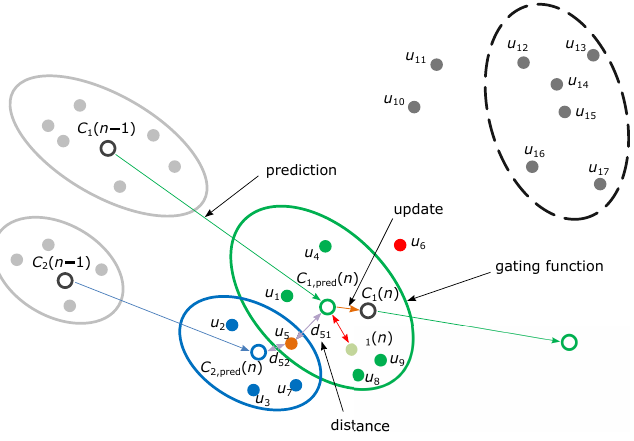
Figure 10. Single step of GTRACK algorithm. Table 2. GTRACK gating parameters for pedestrian detection and tracking.